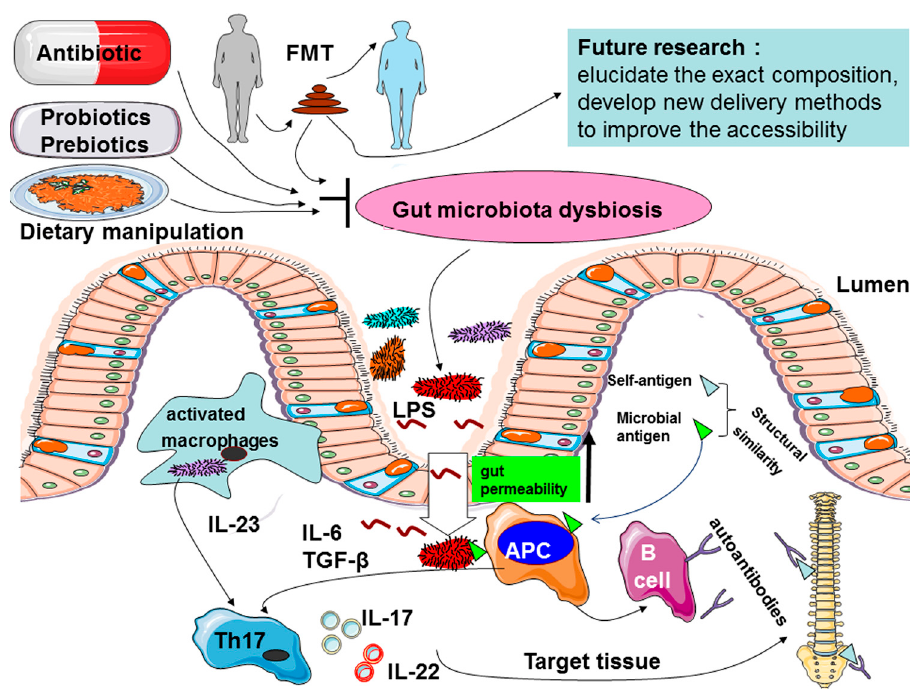
Figure 1. An overview of the possible mechanisms for gut microbiota dysbiosis in causing inflammation in ankylosing spondylitis (AS) and potential targeting alternative therapy strategies aiming to reduce the microbiota dysbiosis. Abbreviations: antigen-presenting cell (APC); B cell: B lymphocyte; fecal microbial transplantation (FMT); T helper cells (Th cells); lipopolysaccharide (LPS).